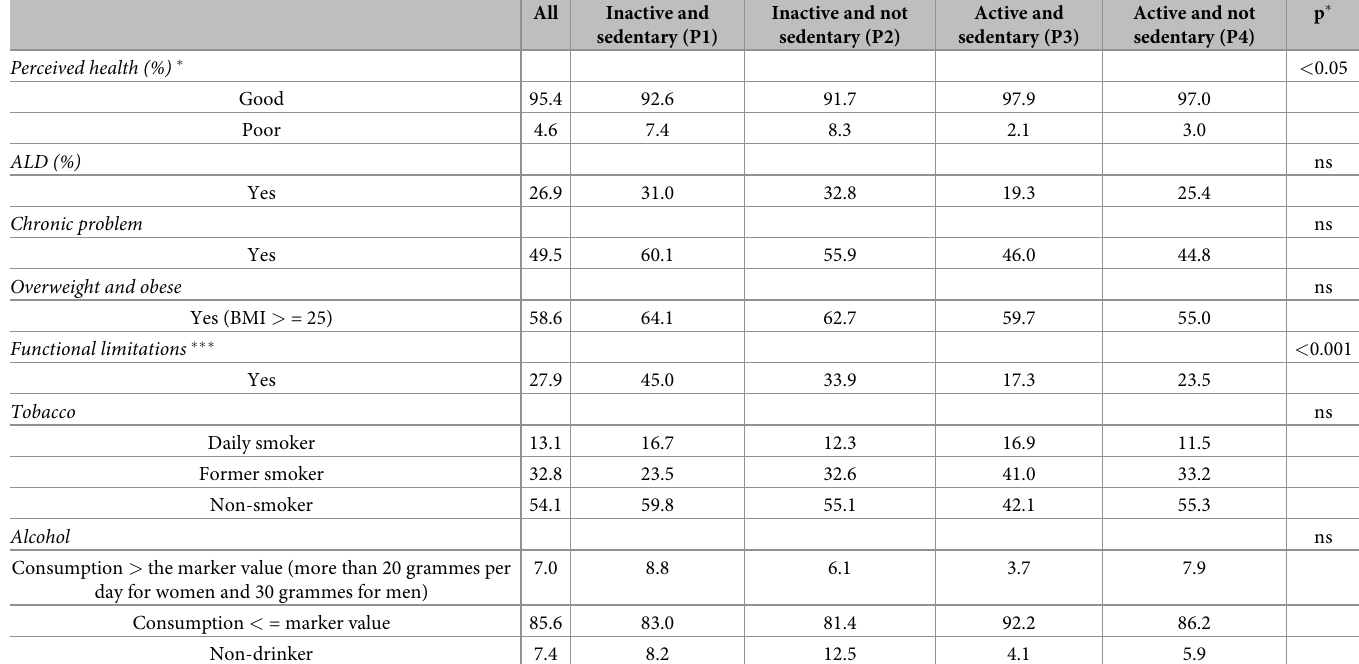
Table 12. Health data by PA & SB